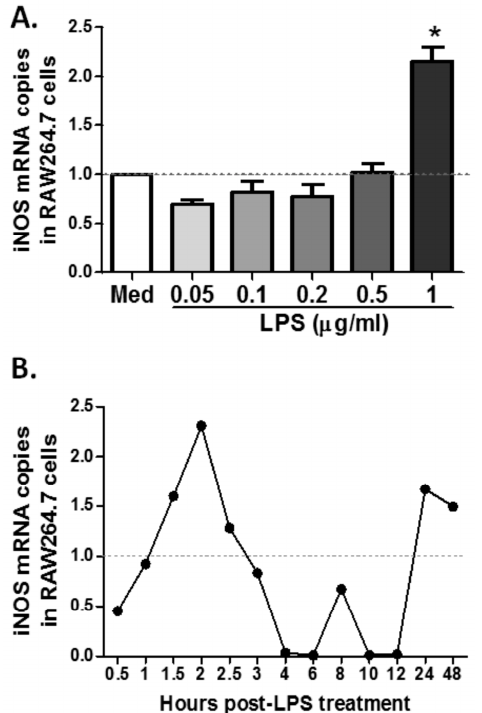
Figure 4. Effects of lipopolysaccharide (LPS) on iNOS production in RAW264.7 cells. RAW264.7 cells were plated in 6-well plates at a density of 1 × 10 6 cells/well in Roswell Park Memorial Institude (RPMI) 1640 medium/10% FCS, treated with different dose of LPS for different times indicated in the figure, and then harvested for evaluating the mRNA levels of iNOS by qRT-PCR. The horizontal dotted line represents the normalized standard of glyceraldehyde-3-phosphate dehydrogenase (GAPDH) mRNA level. The data were the representative mean values of three independent experiments. ( A ) RAW264.7 cells were treated with LPS (0.05–1 µ g/mL) for 2 h; ( B ) RAW264.7 cells were cultured with LPS at 1 µ g/mL for 0.5 to 48 h.